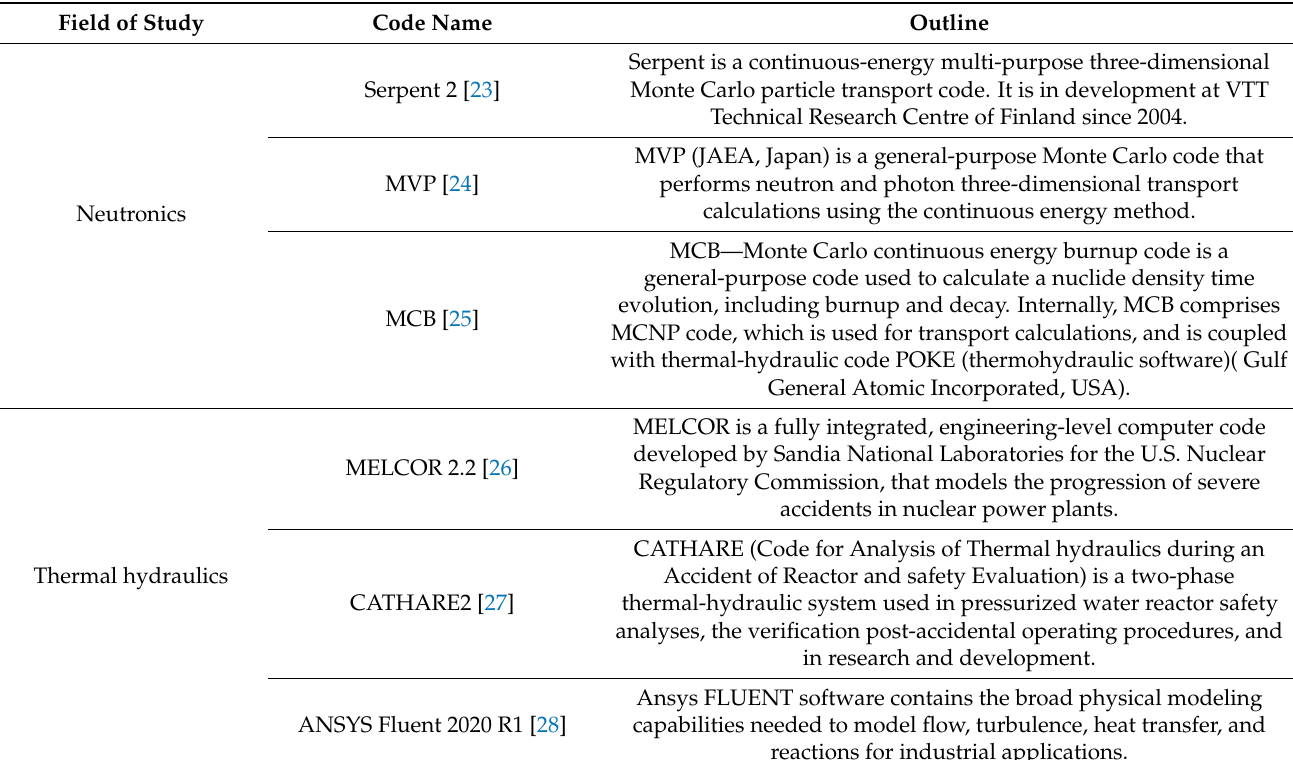
Table 5. Tools used in the partial safety analysis in thermal-hydraulic and neutronic